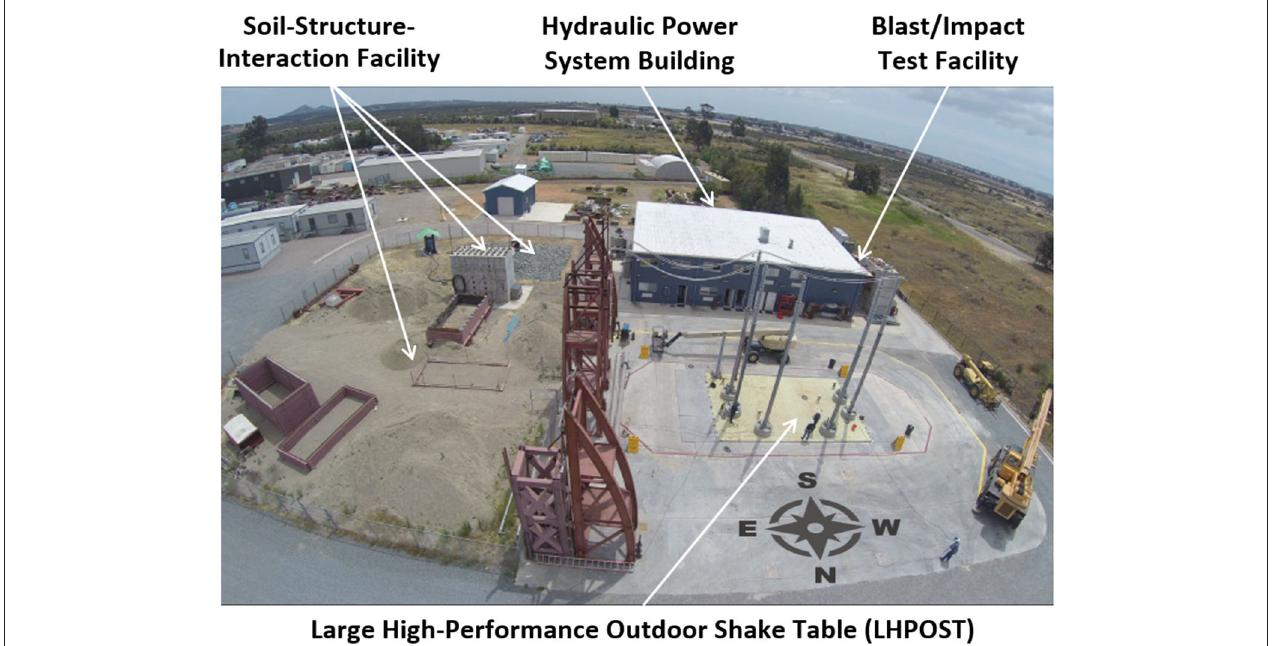
FIGURE 1 | Englekirk Structural Engineering Center at UC San